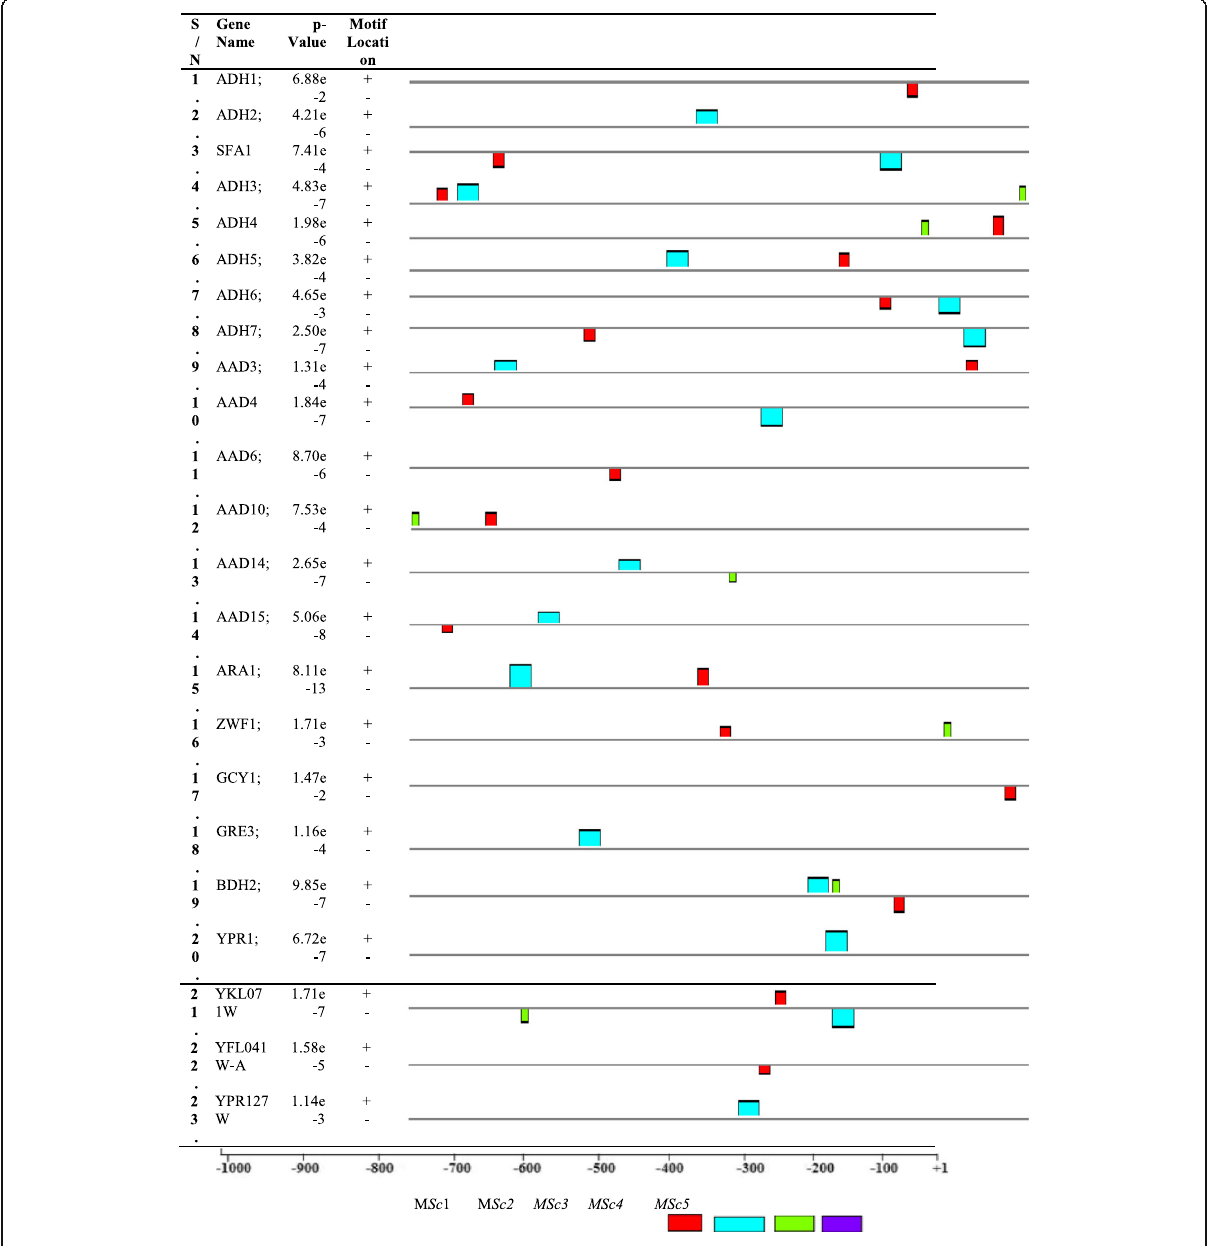
Fig. 3 The relative positions of motifs in alcohol dehydrogenase for S. cerevisiaea S288C sequences relative to